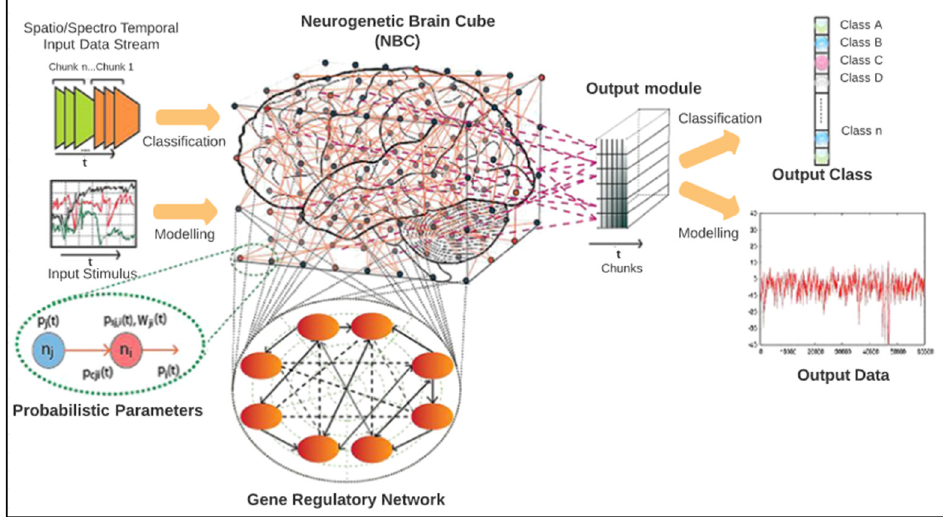
Figure 4. NeuCube model (Source: Kasabov 2012 [6]).